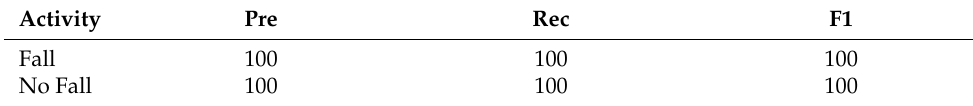
Table 8. Classification rates (%) of the best model of the SisFallB dataset using RF.